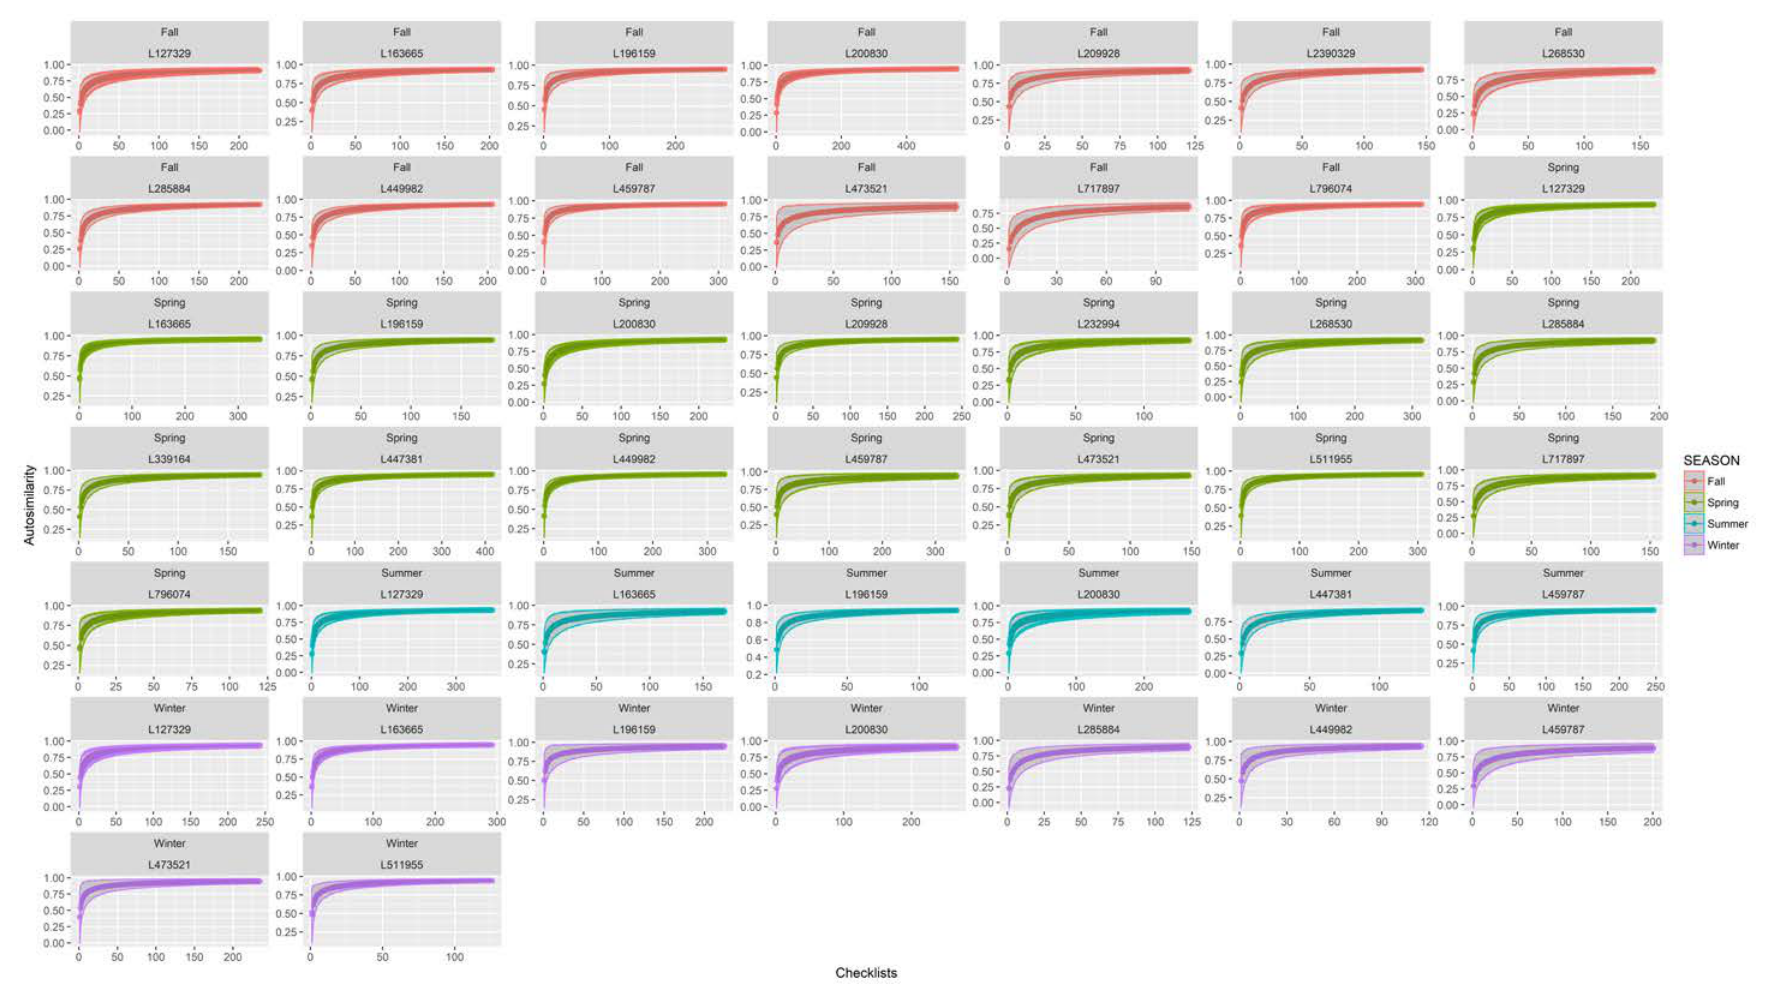
Figure A2.6. Autosimilarity curves for each hotspot/season combination that had >100